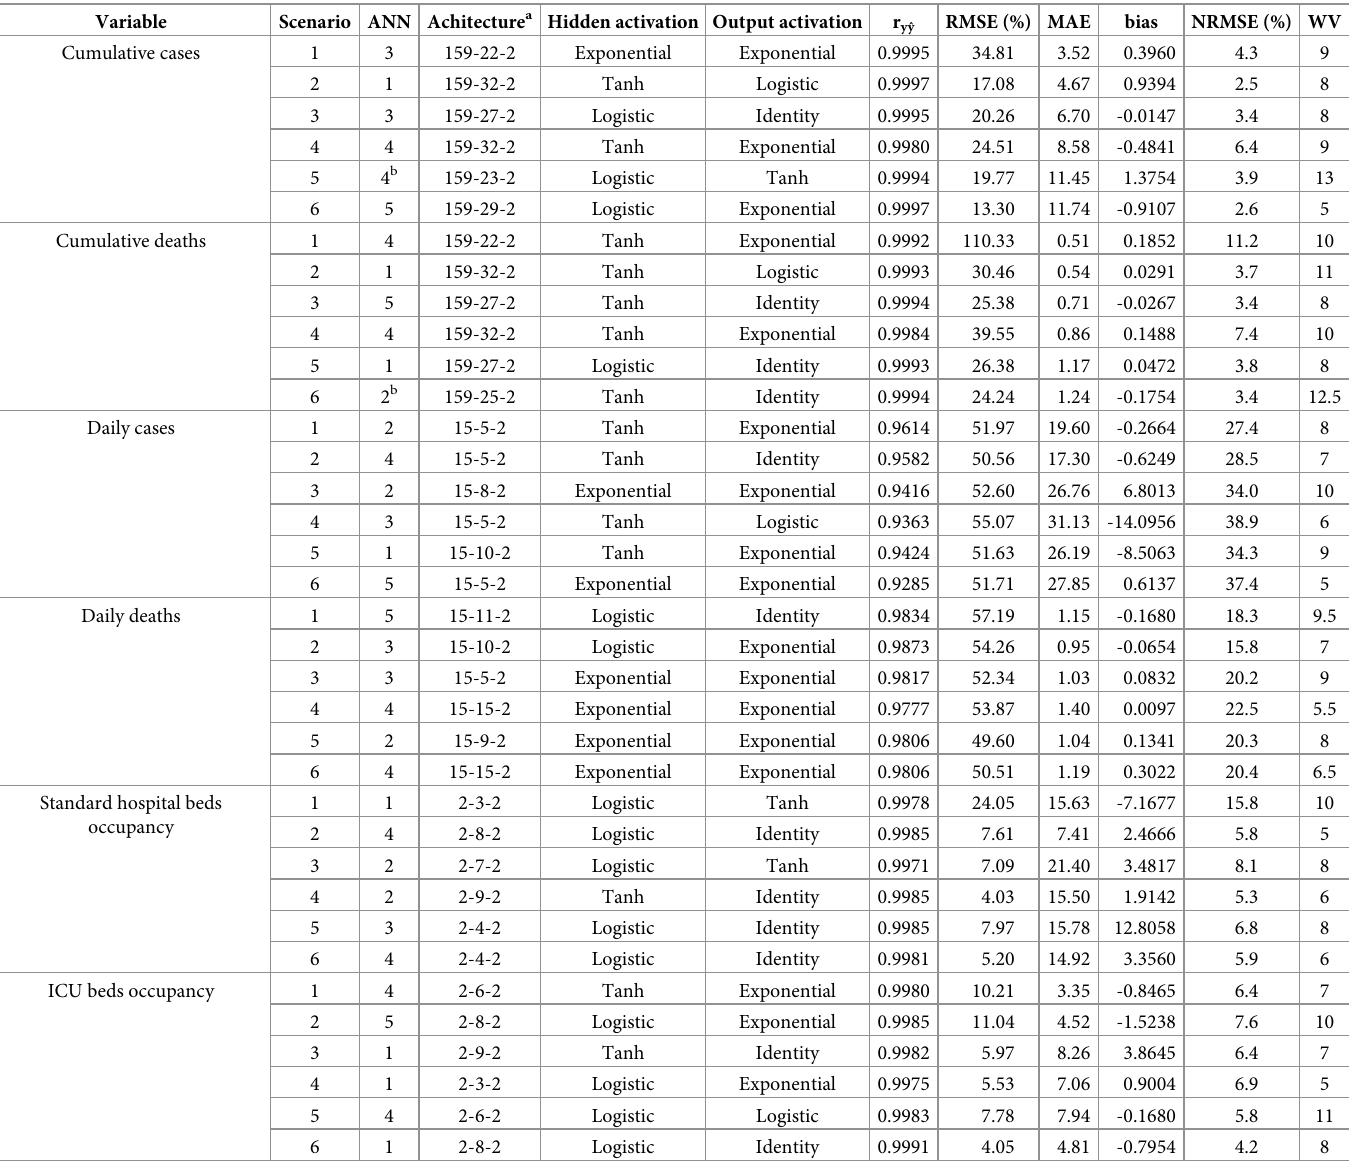
Table 1. Prediction and trend measures of the best ANN for the test